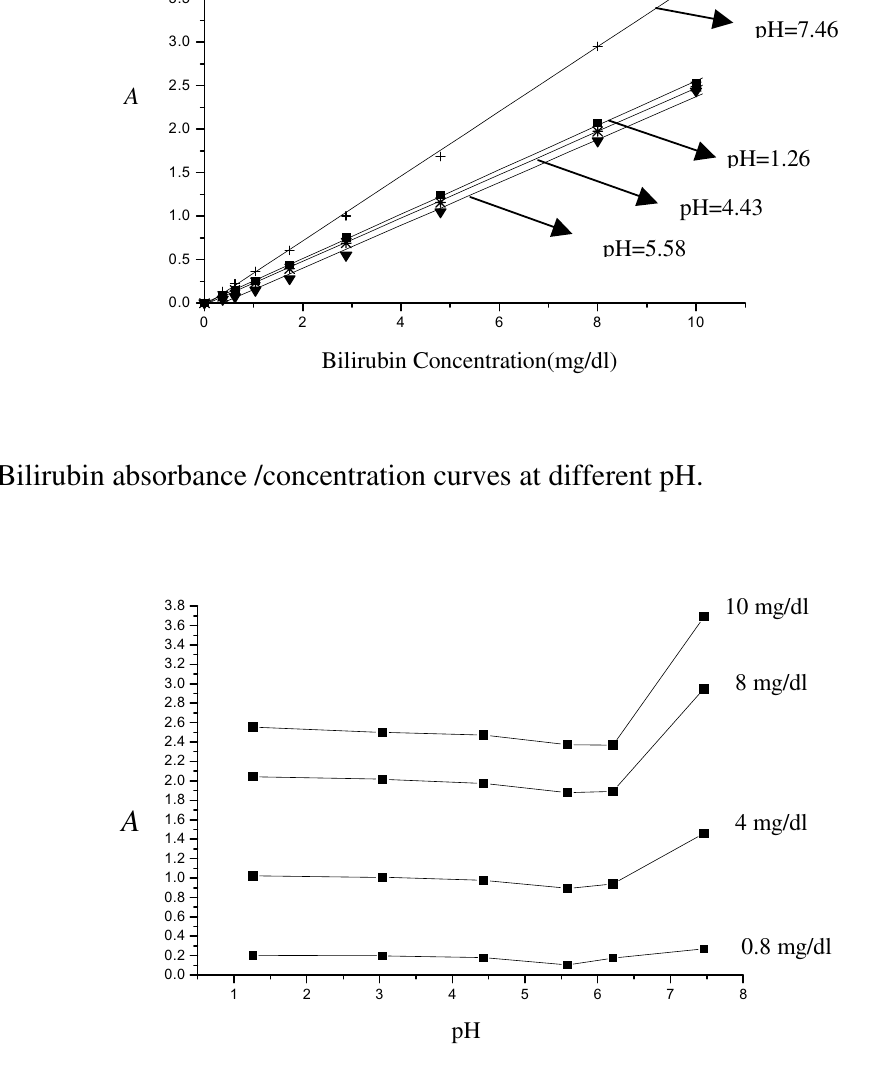
Figure 5. Absorbance of bilirubin with concentrations at 0.8, 4, 8 and 10 mg/dl in the range of pH 1-8. The absorbance A is deduced from the regression lines